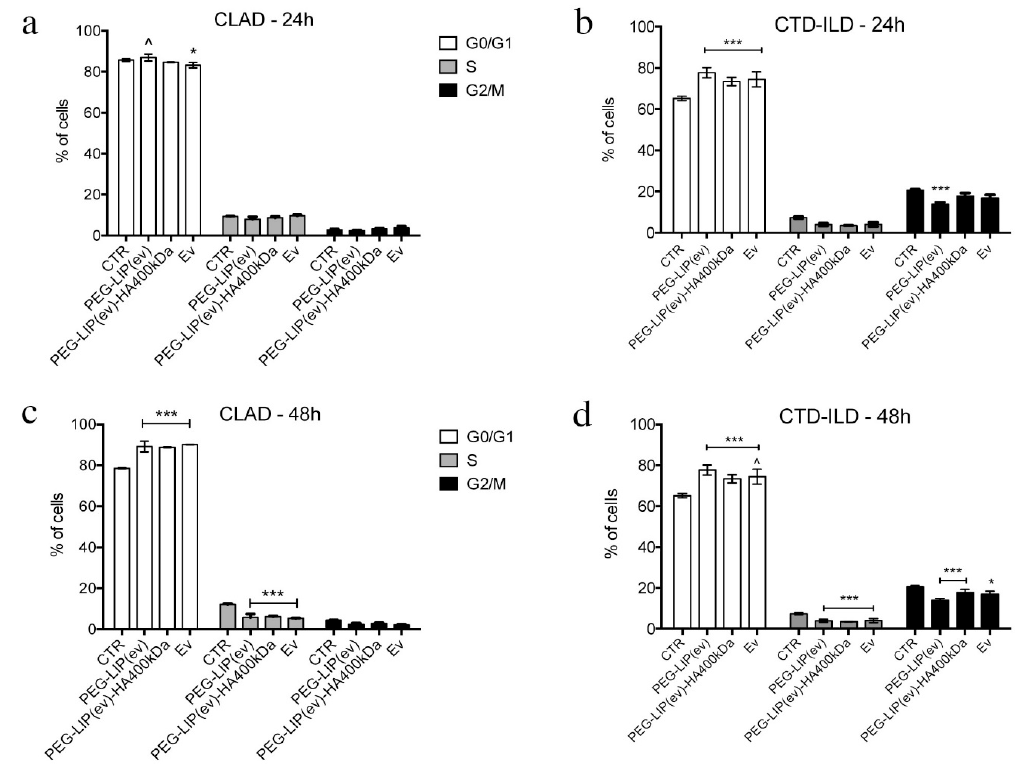
Figure 6. Cell cycle analysis of LFs derived from ( a , c ) CLAD and ( b , d ) CTD-ILD after incubation with liposomes and everolimus alone (50 nM) for ( a , b ) 24 h and ( c , d ) 48 h. Data are represented as mean of percentage of cells ± SD in each cell cycle phase. ***, p < 0.001 vs. CTR; *, p < 0.05 vs. CTR; ^, p < 0.05 vs. PEG-LIP(ev)-HA400kDa. (Two-way ANOVA followed by Tukey post-hoc).